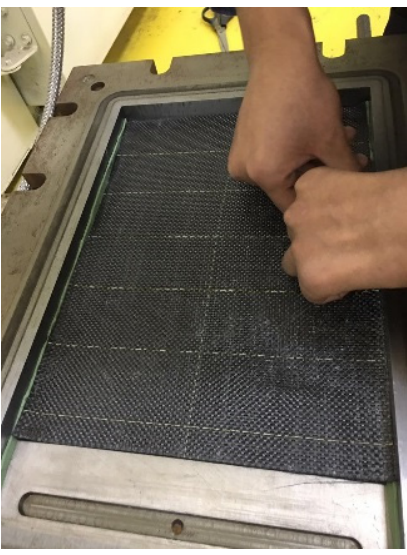
Figure 2. Lay-up process of pre-loaded carbon fiber (CF) preform in resin transfer molding (RTM) mold.